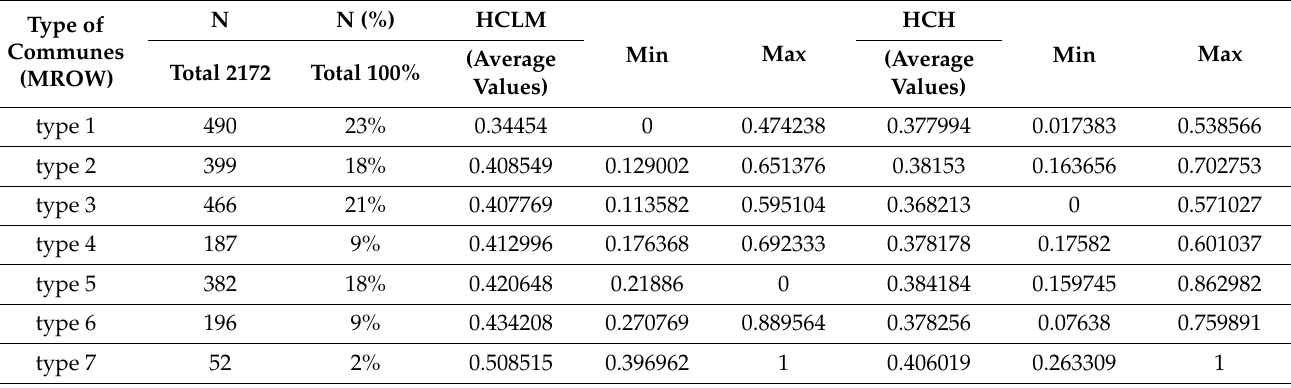
Table 8. The level of human capital in area of health [HCH] and labor market [HCLM] vs. rural areas by MROW. The structures of rural